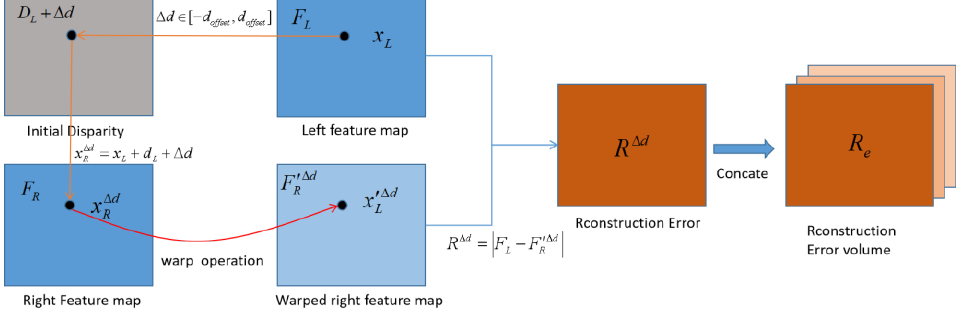
Figure 3. Construction process of the reconstruction error volume